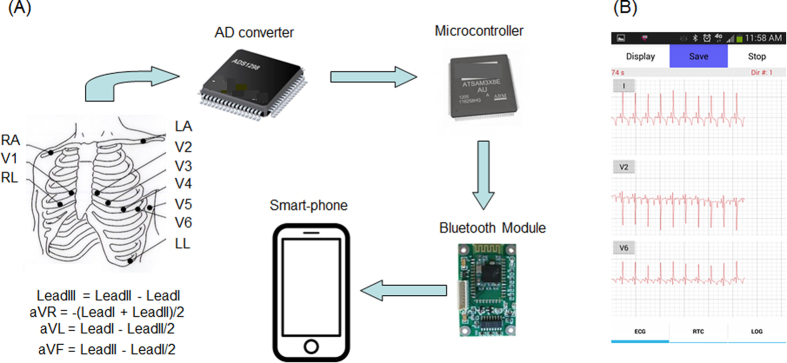
The smartphone-based ECG acquisition system, or “cvrPhone”.The Bluetooth-enabled ECG acquisition system is composed of three commercially available parts: An analog-to-digital (AD) converter, a microcontroller board and, and a Bluetooth module. (A) Flow-diagram of the 12-lead ECG signals from the torso to smartphone. Ten electrodes are placed on the torso for the recording of 8 ECG leads (Leads I and II and six precordial leads). The AD converter amplifies and digitizes the 8 ECG leads. Then the signals are transmitted to the smartphone through the HC-05 Bluetooth module, and the remaining leads (Leads III, aVR, aVL and aVF) are calculated. (B) Real-time display of selected three ECG signals on the smartphone screen.